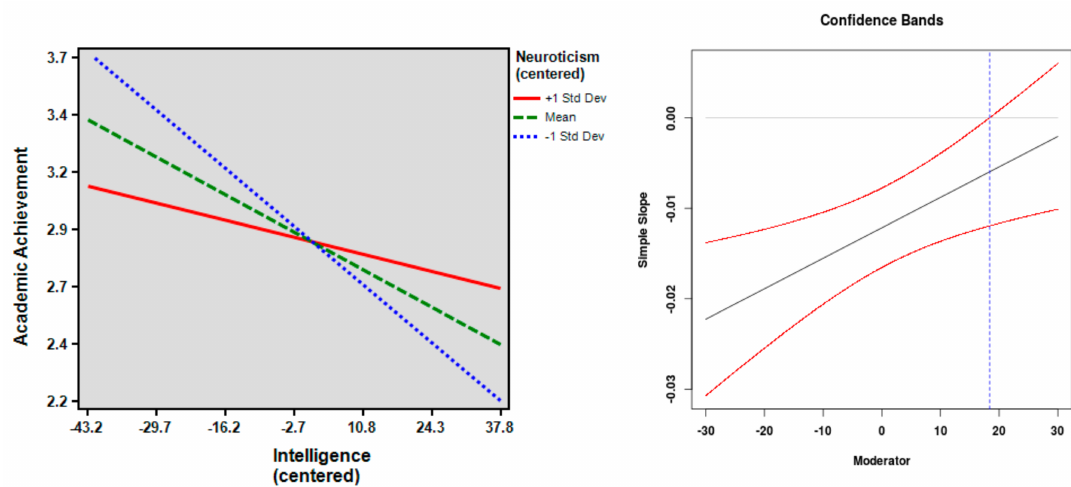
Figure 2. The regression of academic achievement (GPA) on intelligence at high, mean, and low scores on Neuroticism (on the left ) as well as the confidence bands and region of significance (on the right ). The dotted line marks the score of the moderator at which the association between GPA and intelligence becomes statistically significant ( p <